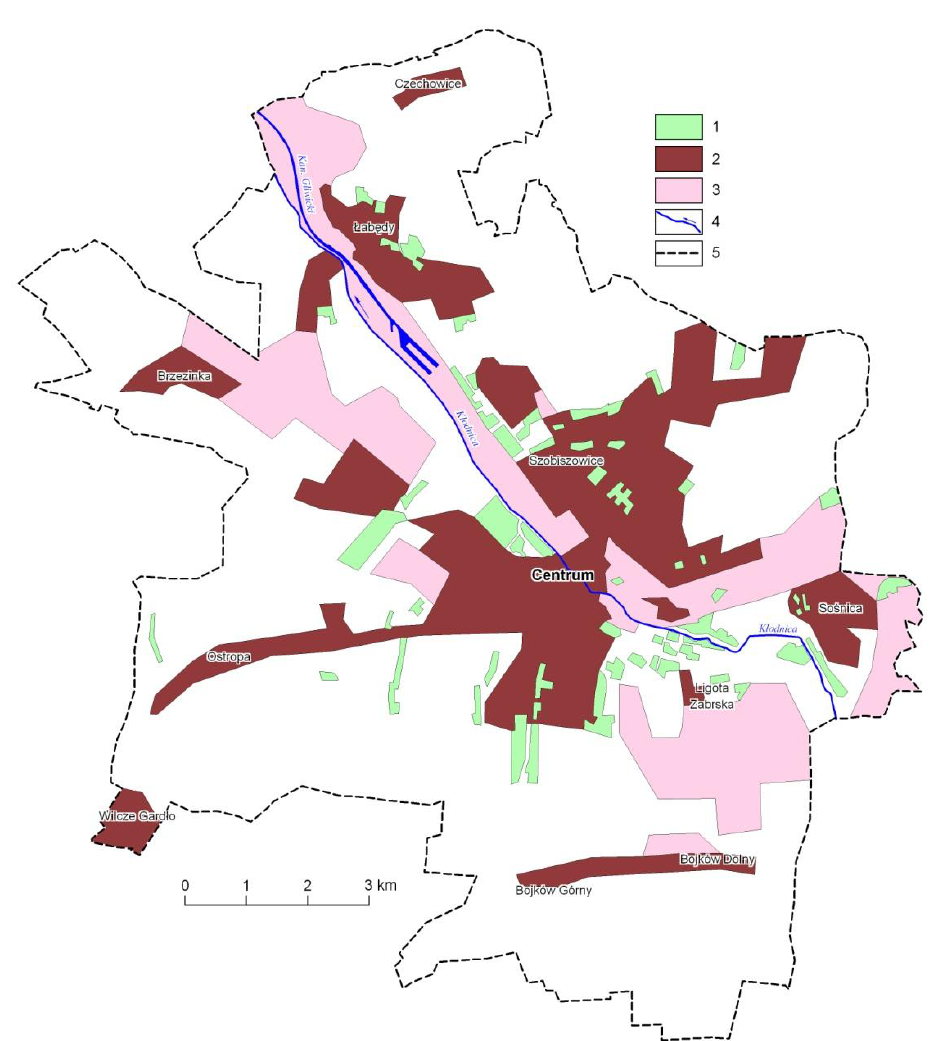
Fig. 2. Allotment gardens against the background of major forms of urban disposal in Gliwice (made by author) 1 - allotment gardens; 2 - residential building; 3 - other areas of urban disposal; 4 - Kłodnica river; 5 - town